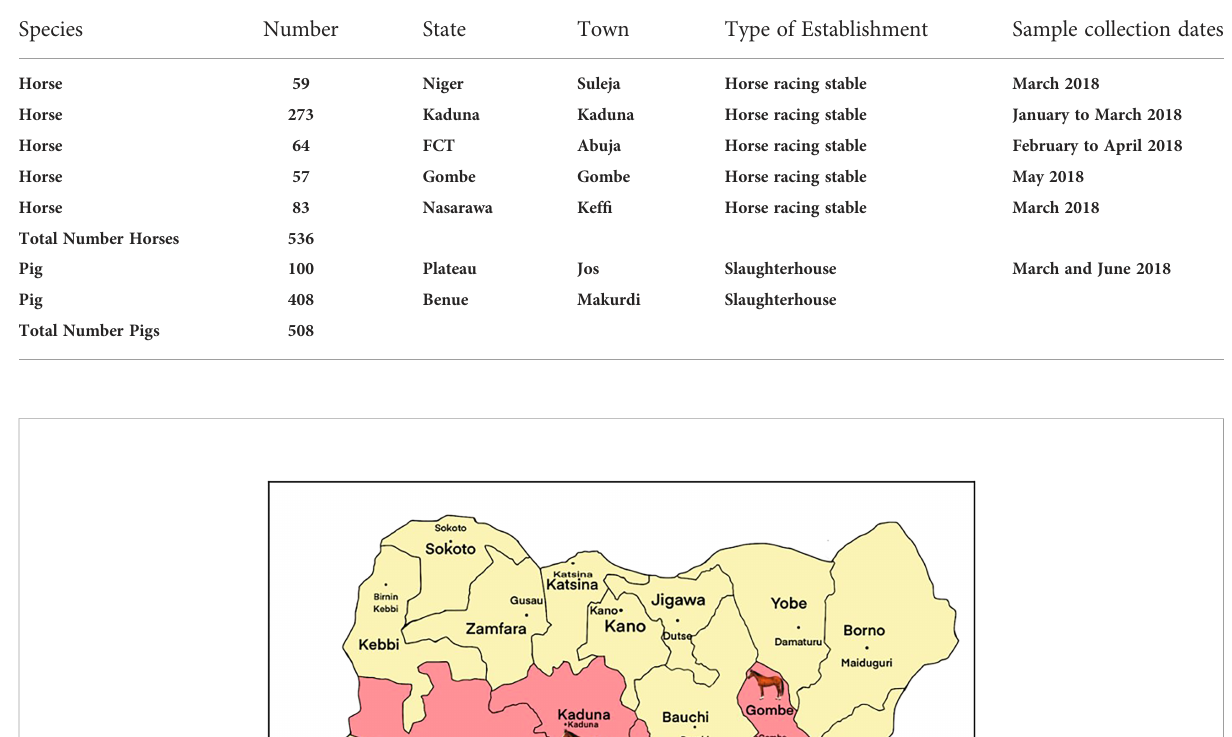
TABLE 1 Species, sampling numbers, locations, and